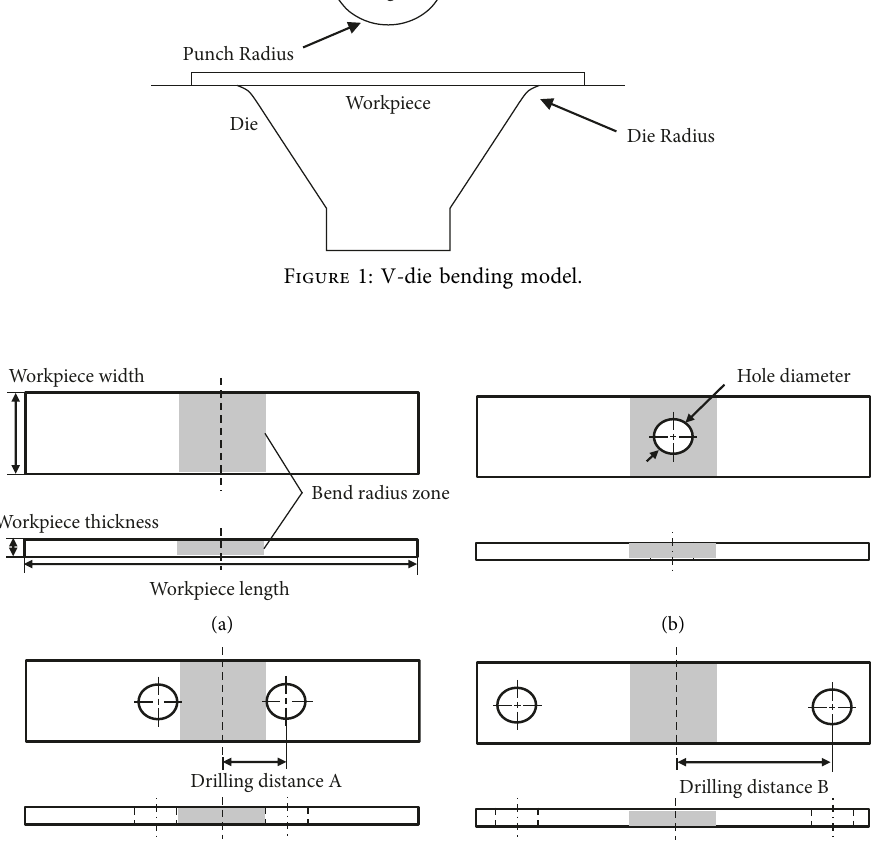
Figure 2: Illustration of hole positions on blank sheet. (a) Without hole. (b) Hole at bend radius zone. (c) Hole at next to bend radius zone. (d) Hole at leg zone.